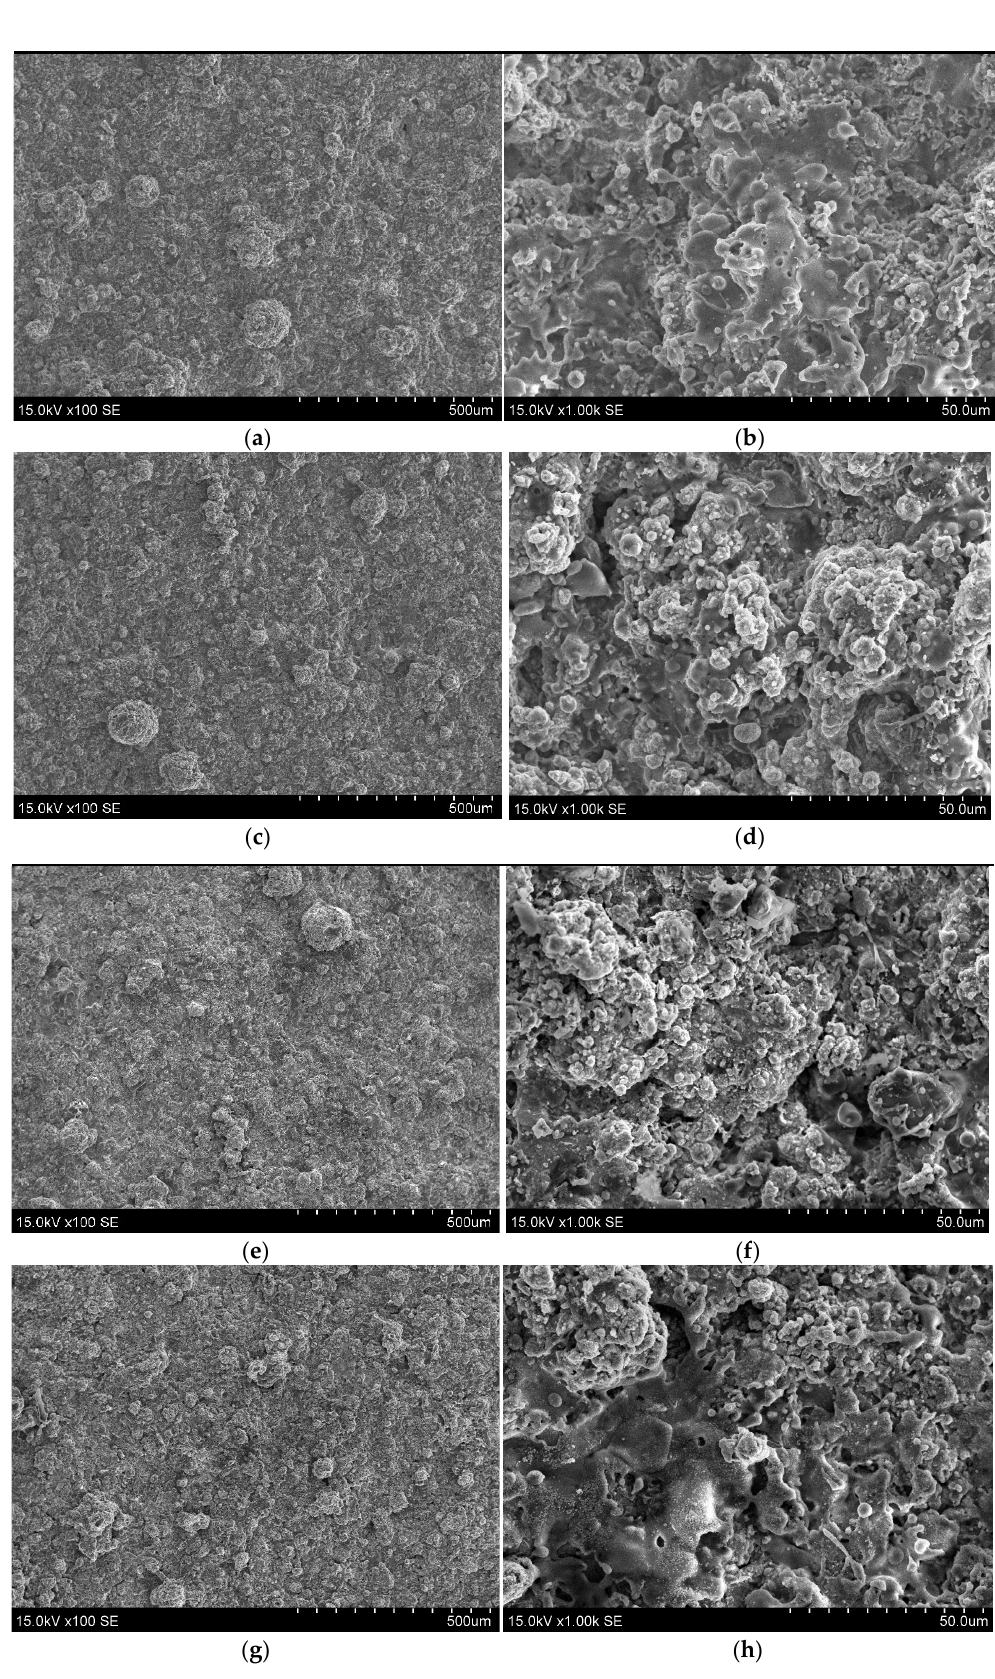
Figure 8. SEM micrographs of Al 2 O 3 coating, before ( a , b ) and after ( c , d ) 5, ( e , f ) 15, and ( g , h ) 25 heat treatment cycles. The surface morphology of Al 2 O 3 -13 wt.% TiO 2 coating is presented in Figure 9. The micrographs show splats and semi-molten particles on the untreated surface: cracks or delamination zones are not visible (Figure 9a,b). After 5 heating cycles (Figure 9c,d), no visible changes can be observed using 100- and 1000-times magnification. After 15 cycles (Figure 9e,f), no cracks are observed; however, some height differences can be seen, since there are some brighter and darker areas. Lastly, after 25 heating cycles (Figure 9g,h), not much difference can be observed; there are some darker and brighter areas on the coating, but no significant damage on the surface was found. The results confirm that Al 2 O 3 and Al 2 O 3 -13 wt.% TiO 2 coatings significantly improved resistance to chemical reactions oc- curring during the combustion processes of straw pellets compared to uncoated steel sub- strates.